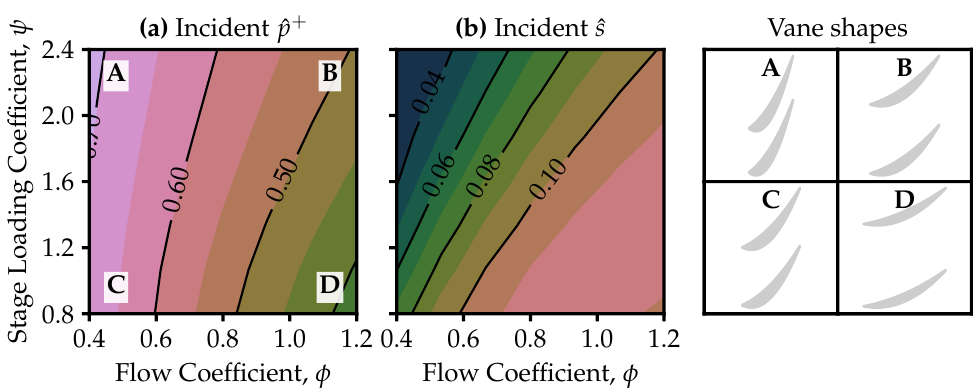
Figure 7. Effect of velocity triangle design on acoustic impedance for incident downstream-running pressure and entropy waves. Pressure wave reflection coefficients are most sensitive to flow coeffi- cient. Entropy–acoustic reflection increases for low-turning